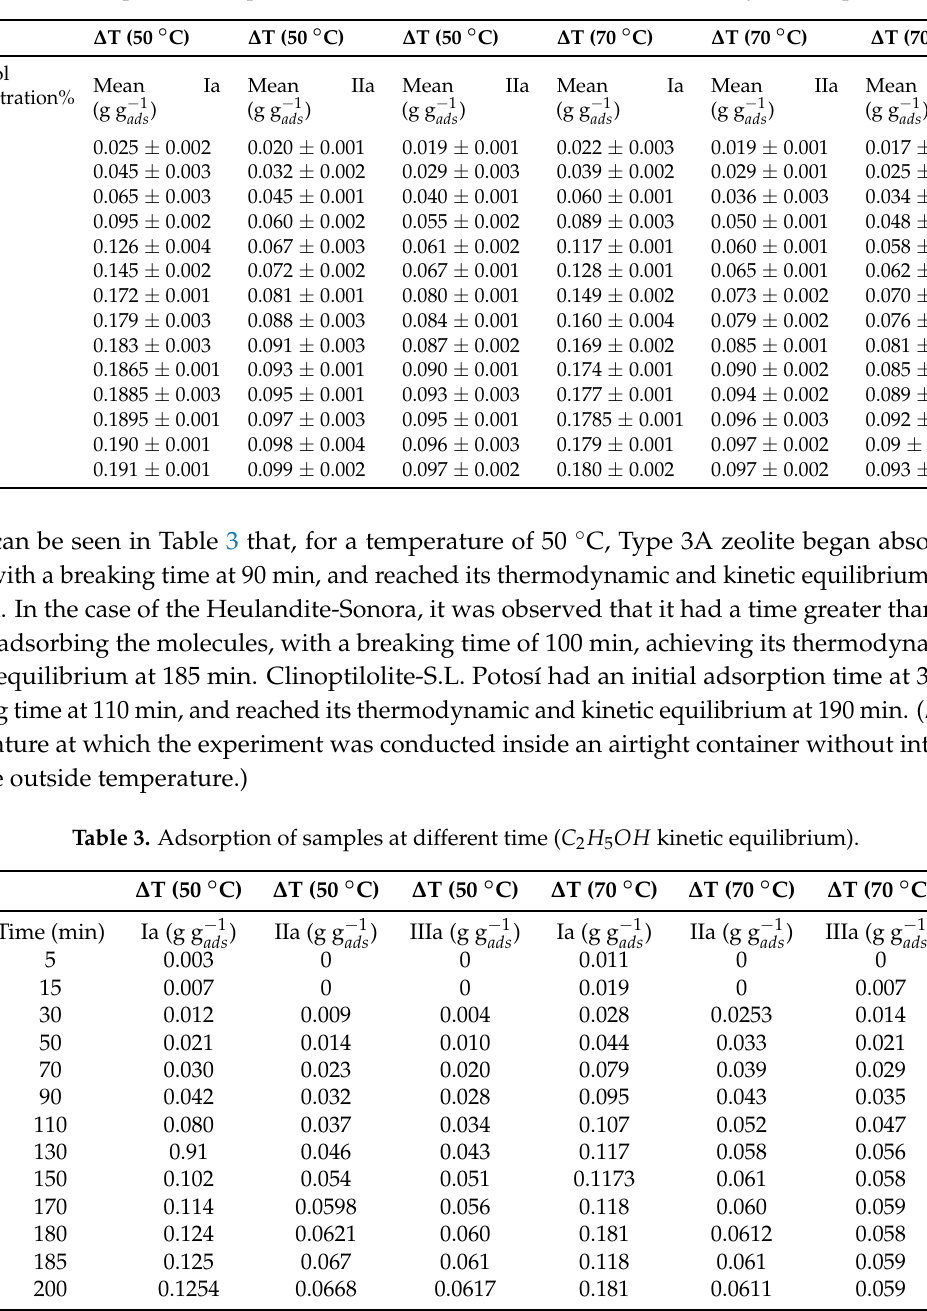
Table 2. Adsorption of samples at different concentrations ( C 2 H 5 OH thermodynamic equilibrium).